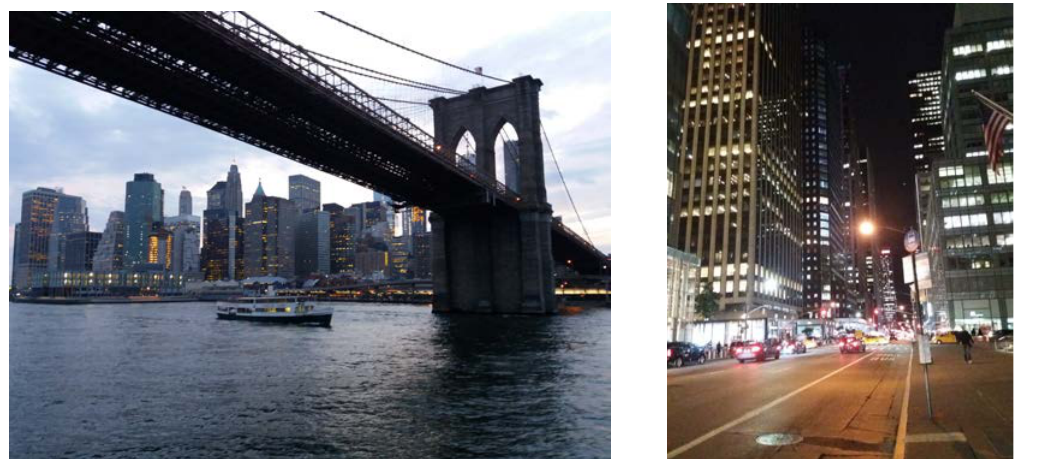
Figure 10: New York – (left) Brooklyn Bridge and a section of the skyline; (right) Avenues and the city lights